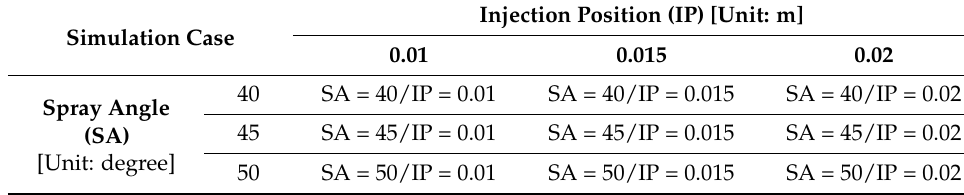
Figure 3. Schematic of the SA and IP adjustments. Table 3. Summary of the simulation cases.